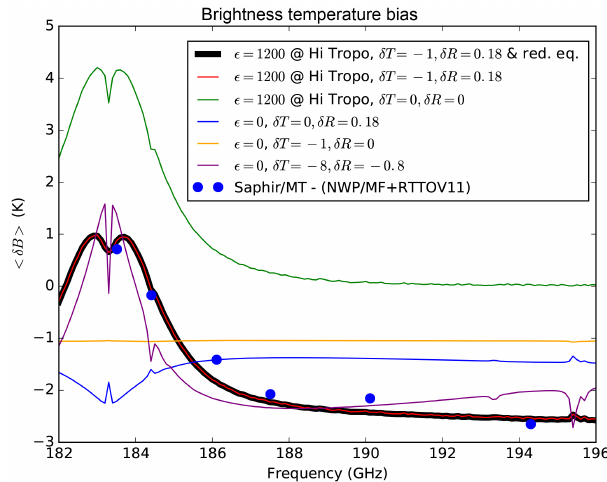
Figure 5. Same as Fig. 4, but setting parameters to analyze the be- havior of the different terms in the Taylor expansions from Eqs. (3) and (5). The full Taylor expansion (Eq. 3) is used to calculate all the lines in this plot except for the black line, which uses the reduced Taylor expansion from Eq.